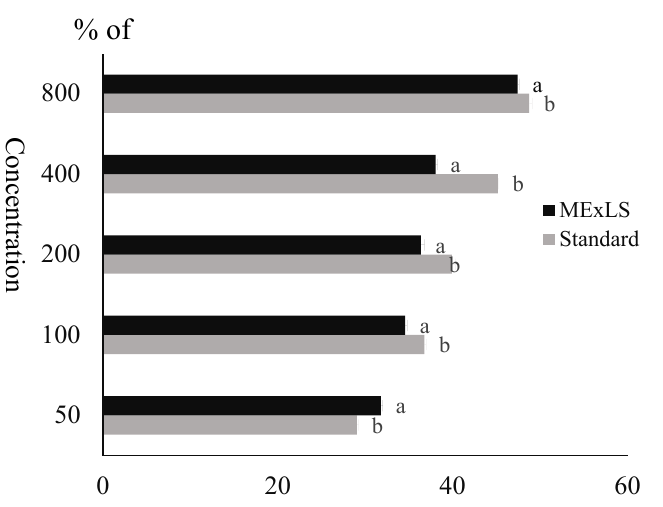
Figure 2. Percent of acarbose and ME X LS’s ability to inhibit α -amylase. A t -test was used to determine the significance of the data after being processed by the analytical program GraphPad Prism, where a significance threshold of p < 0.05 was used. The letters a and b over the bar graph indicate that the values are significant when they are compared to each other.